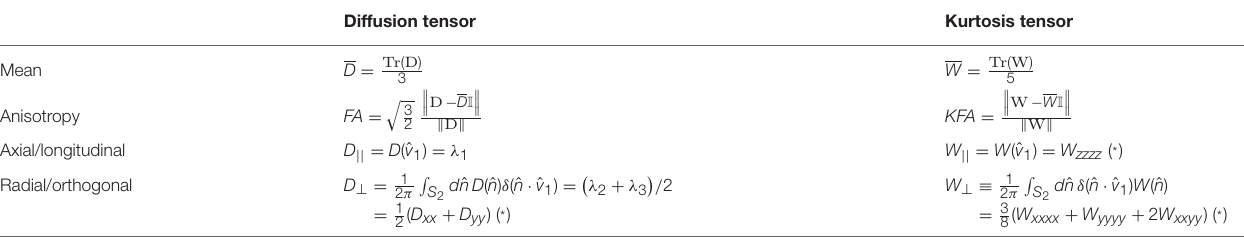
TABLE 2 | Summary of the fast kurtosis metrics definitions and their DTI counterparts. Diffusion tensor Kurtosis